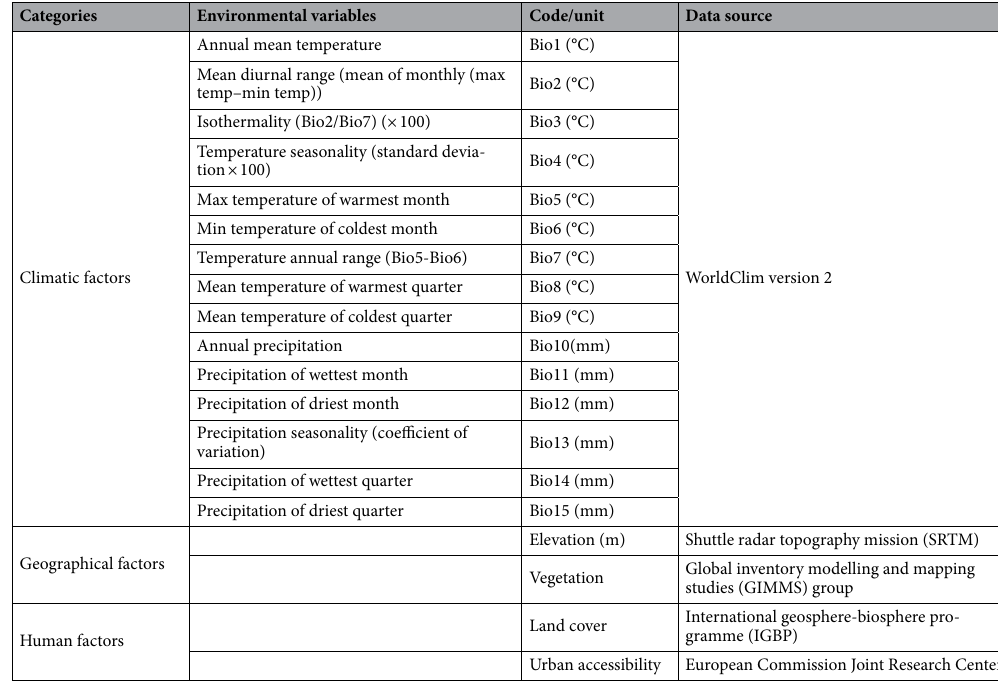
Table 1. Nineteen (19) variables used for mapping the global distribution of O. monoceros and O. rhinoceros with the code and